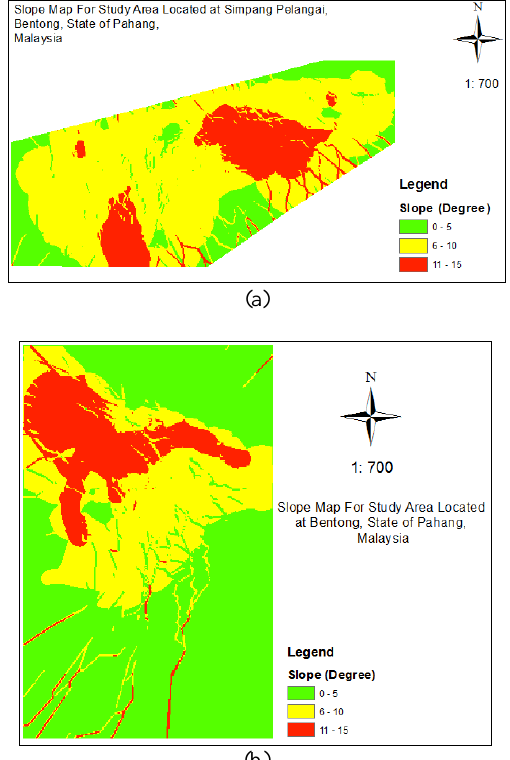
Figure 8. Slope map for (a) rubber trees area, and (b) mixed forest area.